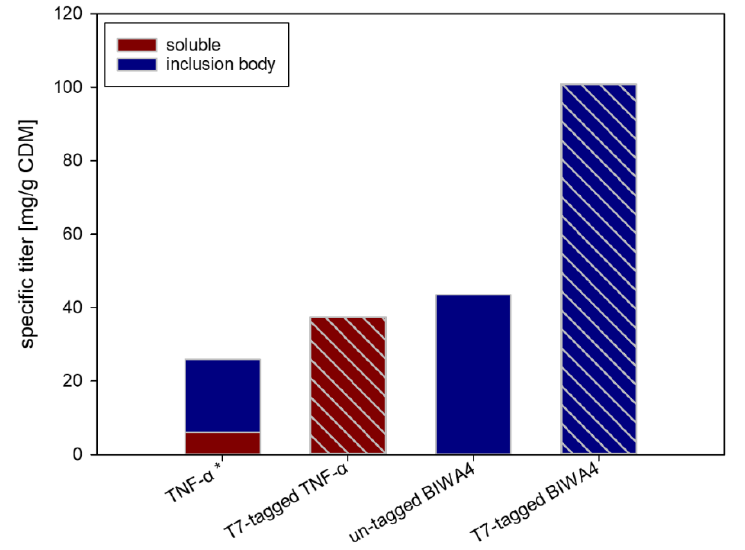
Figure 2. Comparison of specific fermentation end titers of TNF- α and BIWA4. Textured bars represent the T7-tagged constructs. Fusion protein sequences are as follows: 6His_L 1 _CS_TNF- α (TNF- α ), CASPON_TNF- α (T7-tagged TNF- α ), CASPON_BIWA4 (T7-tagged BIWA4). The star (*) denotes constructs that have been expressed in the periplasm with ompA SS . Constructs are described in detail in Table 2. All values represent stoichiometric pure POI